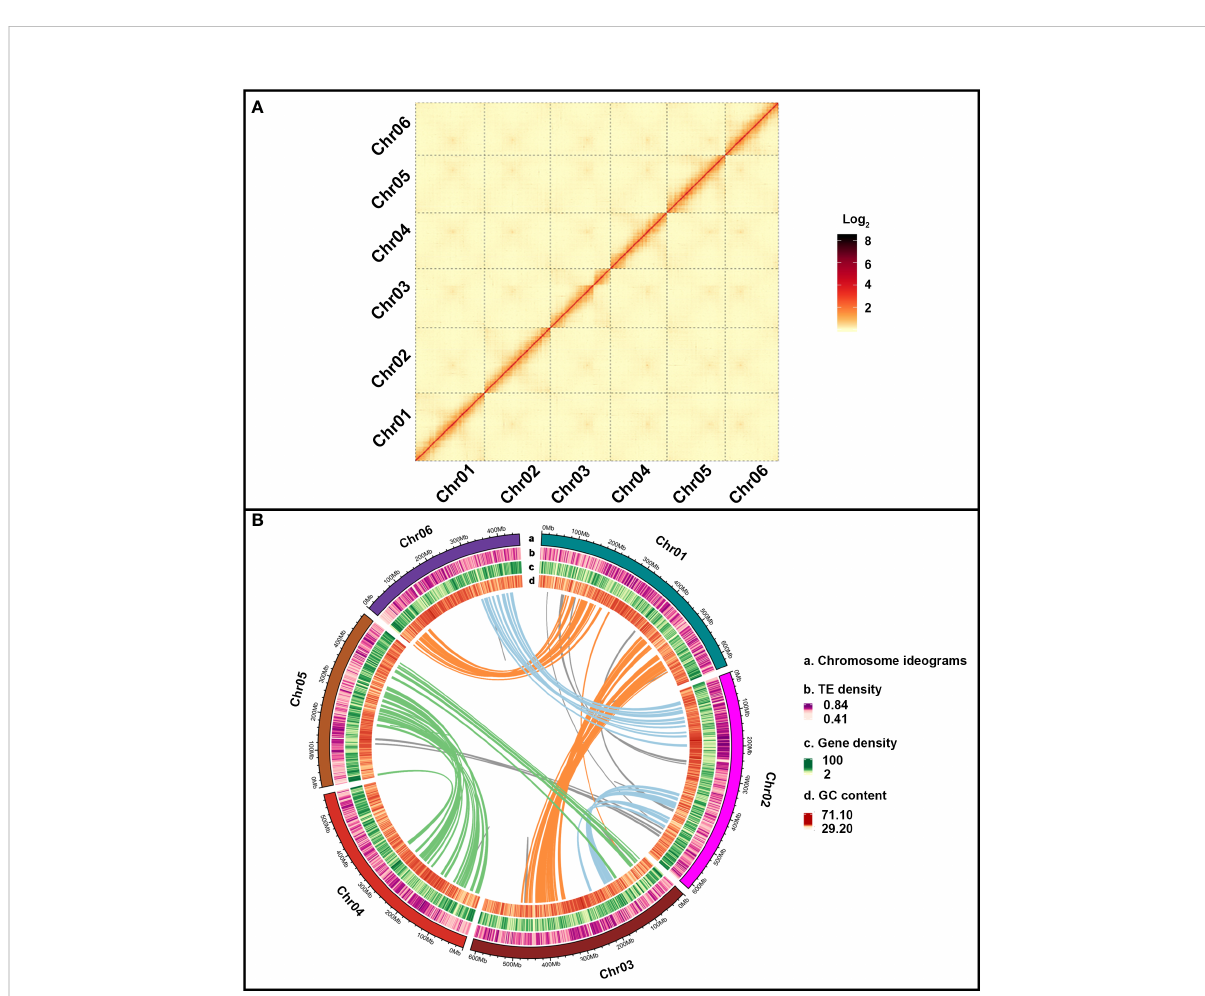
FIGURE 2 E . pubescens genome assembly. (A) Dotplot of E . pubescens syntenic blocks from Hi-C (High-throughput chromosome conformation capture) genome assembly. Each red segment was marked by different pseudo-chromosome label on the X and Y axis. (B) Circos graph of E . pubescens genome assembly. From outer to inner circles, the outer circle of (a) illustrated 6 chromosomes of E . pubescens ; the inner circles of (b – d) showed TE density, gene density and GC content. The solid color lines inside all the circles represented segmental duplication relationships between syntenic blocks of different chromosomes, Chr01-Chr06 and Chr01-Chr03 with orange lines, Chr02-Chr06 and Chr02-Chr03 with light blue lines, Chr03-Chr05 and Chr04-Chr05 with green lines and others with grey